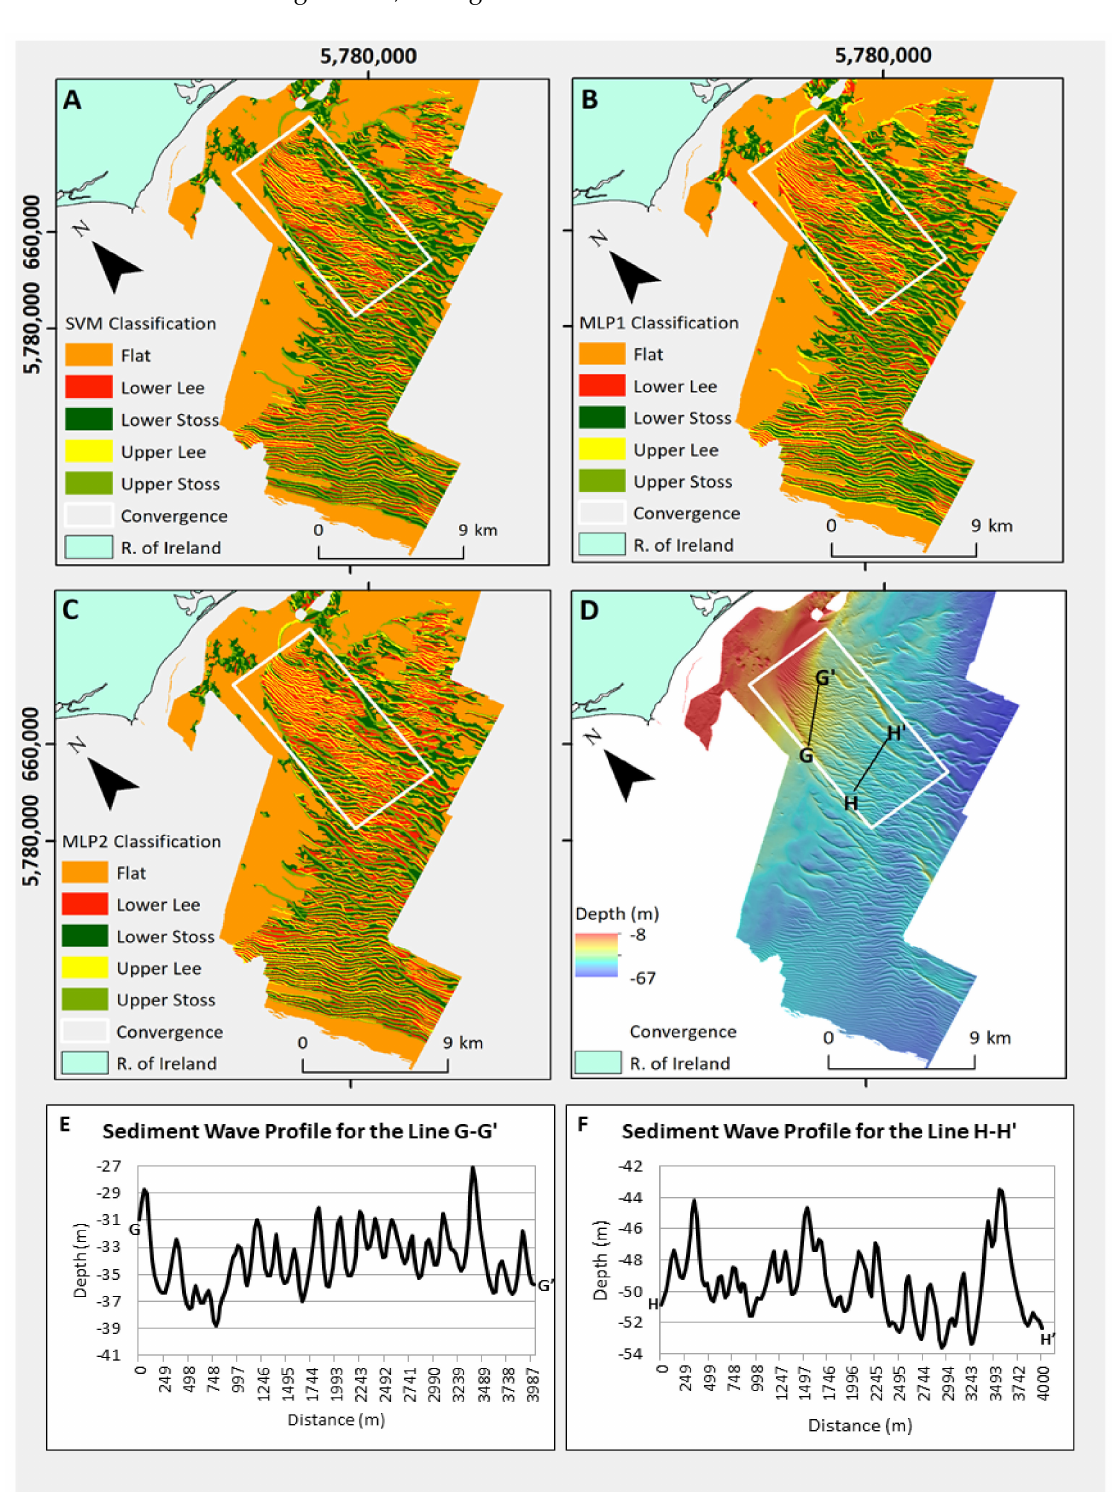
Figure 9. Classification maps for the southern section of the OSW including an outline for the convergence zone between the SW and SW OSW. ( A ) SVM classifier, ( B ) MLP1 classifier, and ( C ) MLP2 classifier. ( D ) Bathymetry for the corresponding region including the line for the sediment wave profile for line G–G’ and line H–H’ displayed in ( E ) and ( F ),